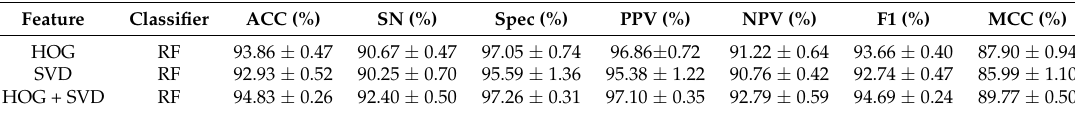
Table 1. Analyze the performance of the Histogram of Oriented Gradient (HOG) and Singular Value Decomposition (SVD) on S . cerevisiae dataset by Random Forest (RF) classifier.